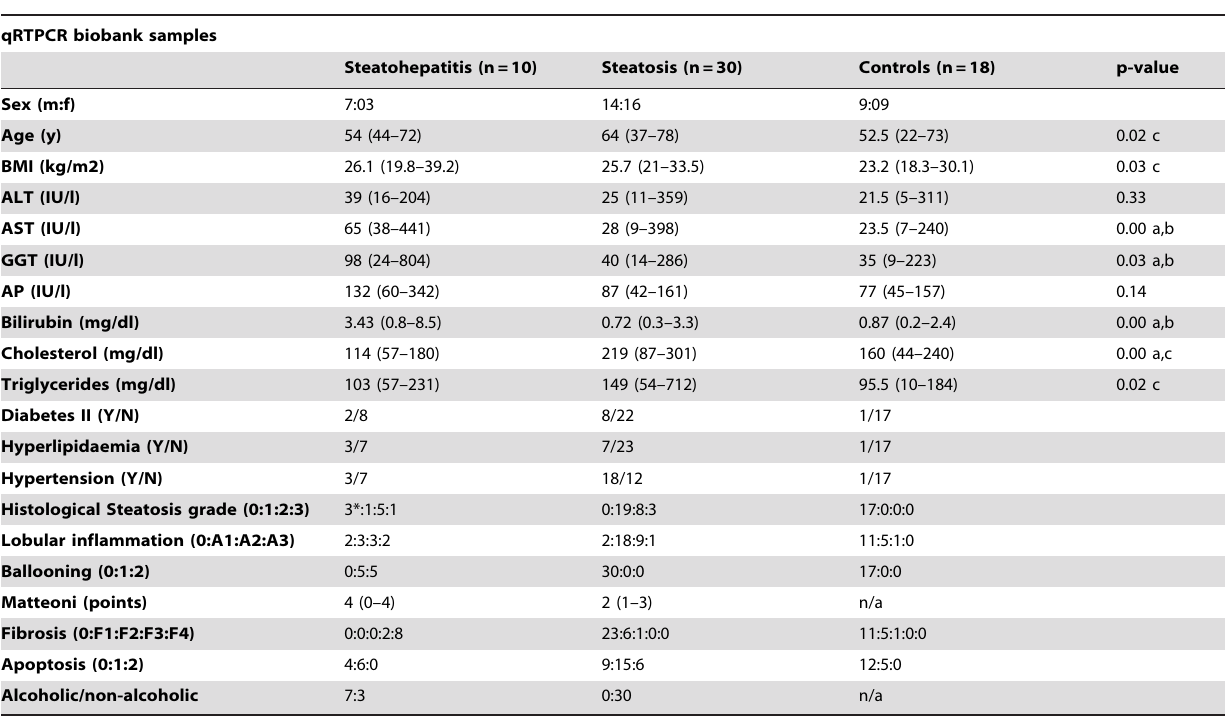
Table 2. Clinical, biochemical and histopathological patient characteristics.